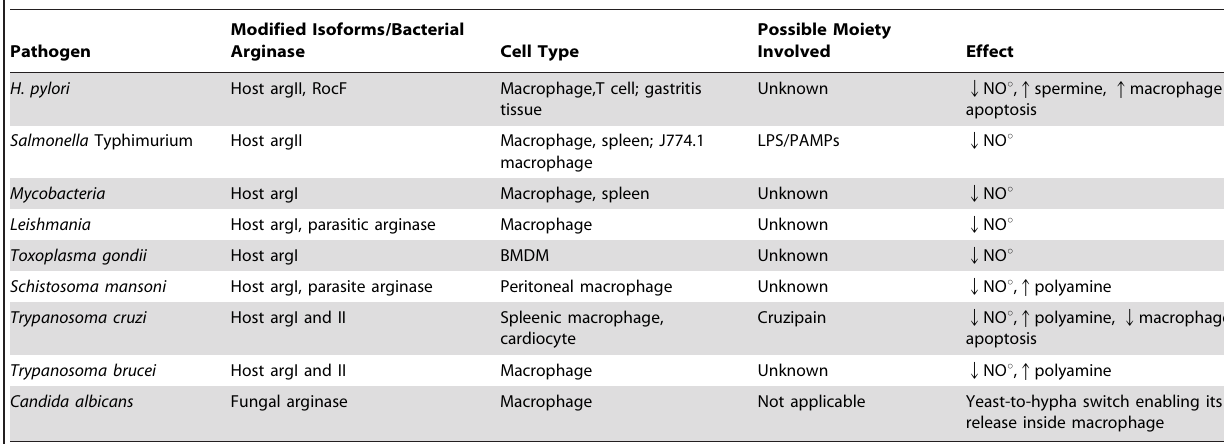
Table 1. Modulation of arginase by various